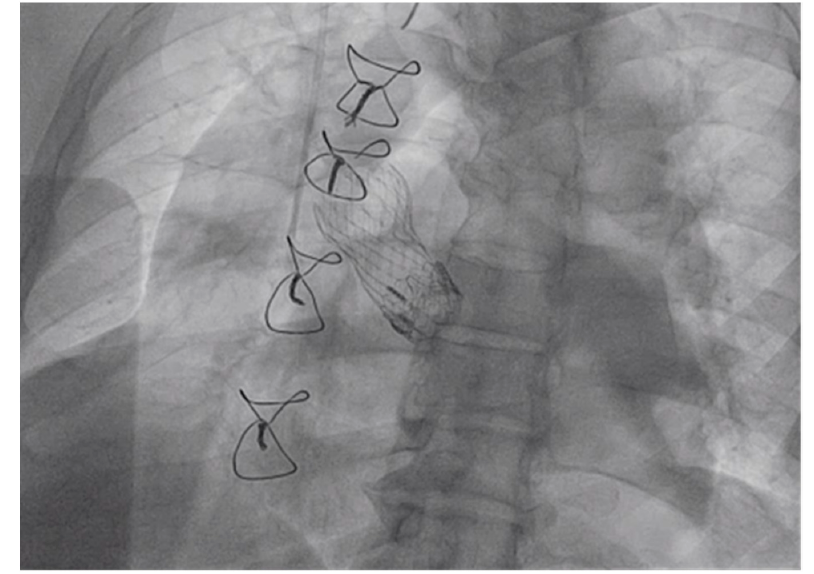
Figure 5. Left Anterior Oblique (LAO) view: Valve is deployed.